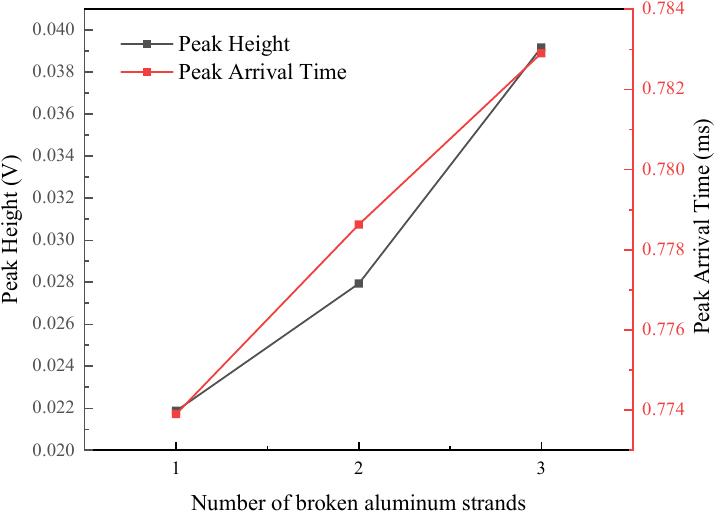
Figure 10. Relationship between the peak value, the peak arrival time, and the different number of broken aluminum strands. Next, the difference between the experimental data with broken steel strands that contained no damage to the Al strands and the reference signal was calculated, and the different output voltage amplitudes were obtained (Figure 11). It can be observed from Figures 4 and 11 that the experimental data of the steel strands were consistent with the related simulation